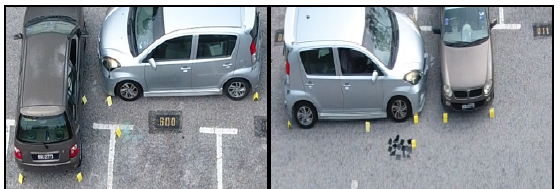
Figure 9. Some examples on marker with label for investigations Then, the measurements are taken at the accident scene.